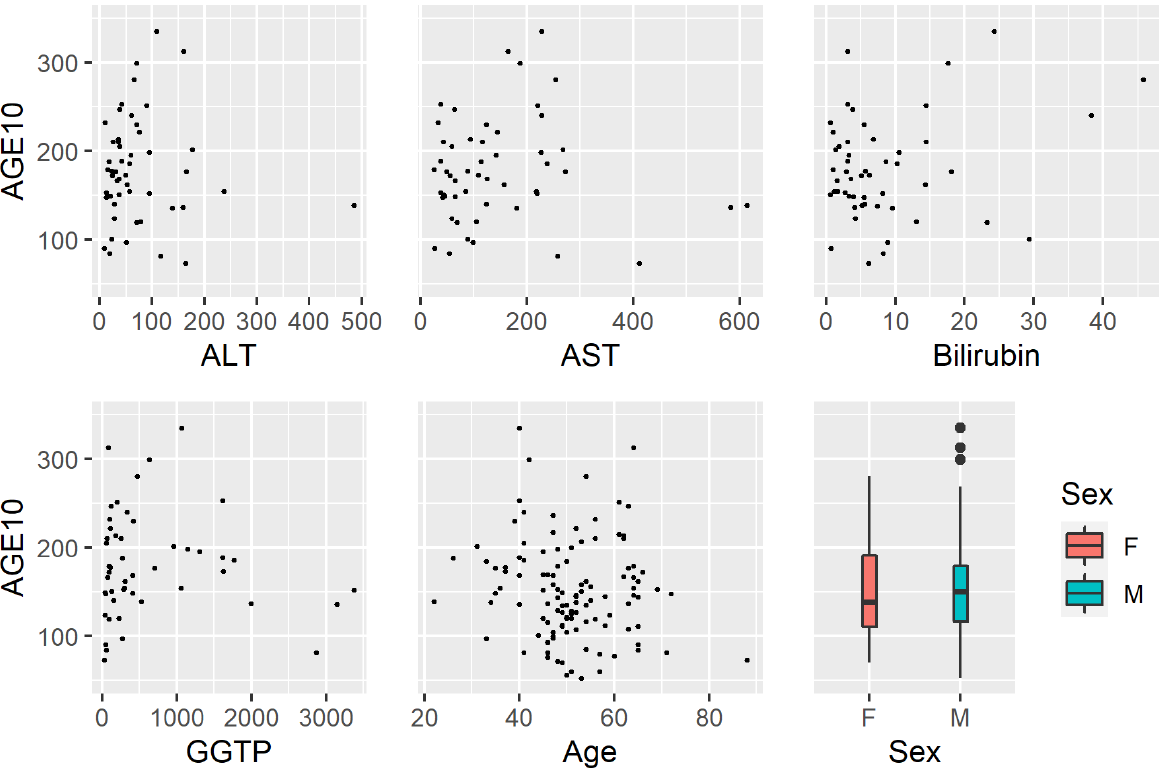
Figure 2. Association between AGE10 and patient characteristics.